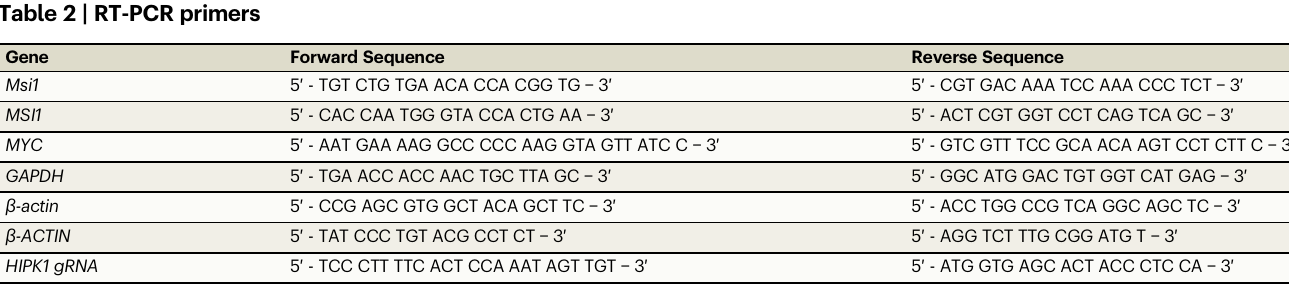
Table 2 | RT-PCR primers Gene Forward